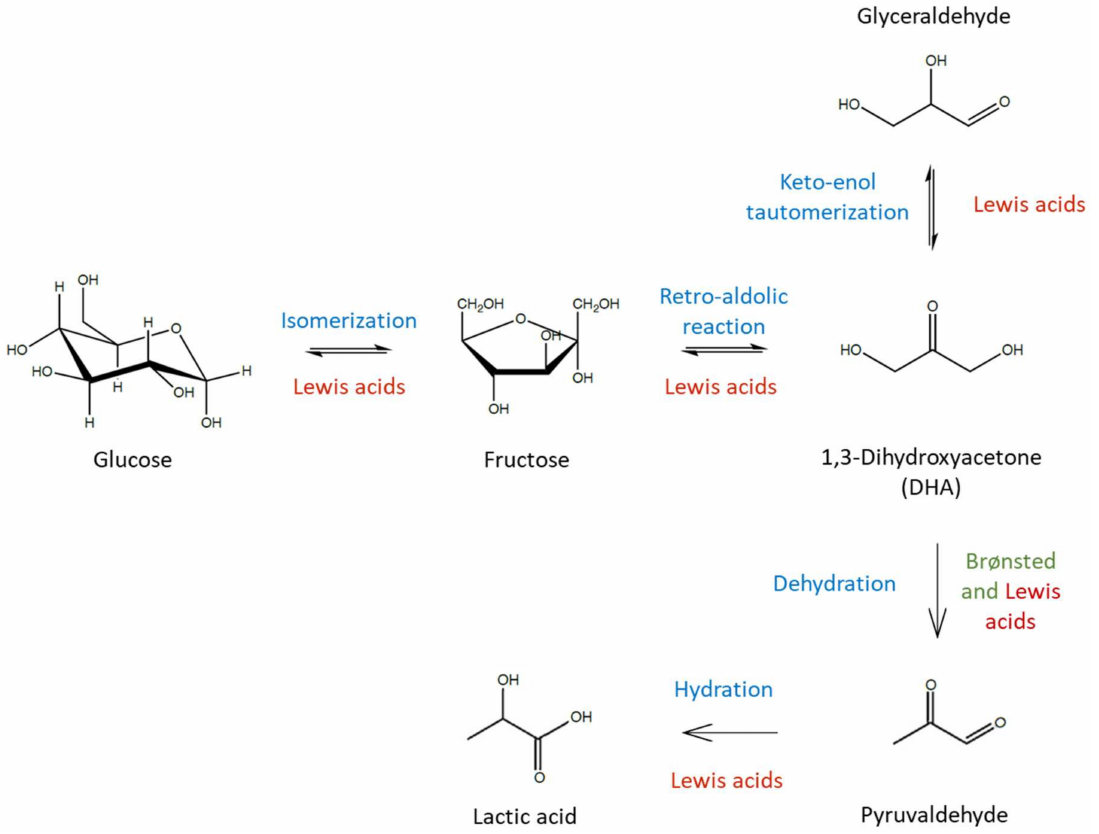
Figure 3. Brønsted/Lewis acid-catalyzed conversion of glucose to lactic